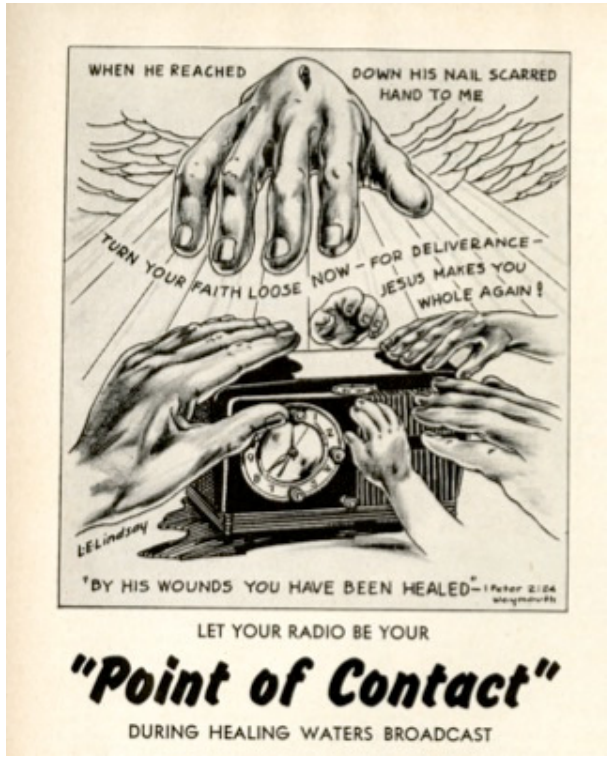
Figure 1 . Illustration from Healing Waters Magazine . Figure 1. Illustration from Healing Waters Magazine